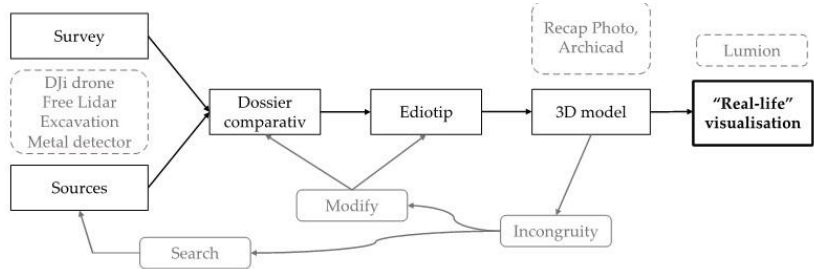
Figure 13. Extended pipeline with applicable tools.